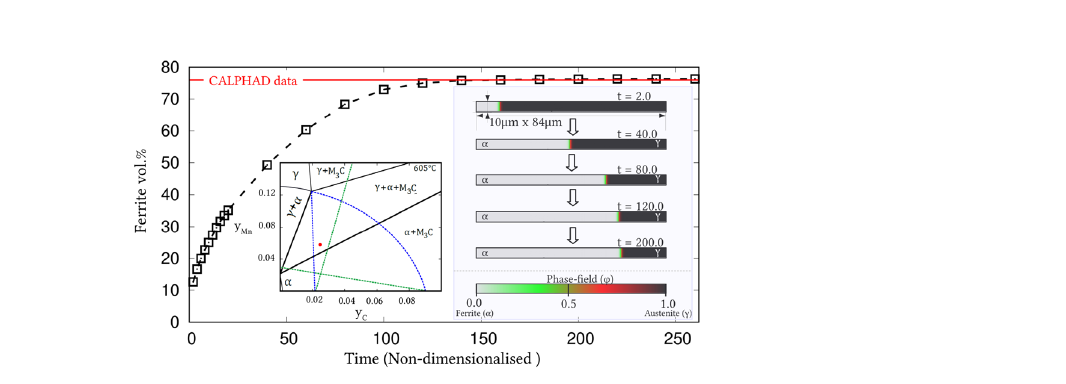
Figure 7. Change in the vacancy concentration with time, owing its reverse diffusion complementing the migration of carbon. The undisturbed site-fraction of matrix-Fe is shown.